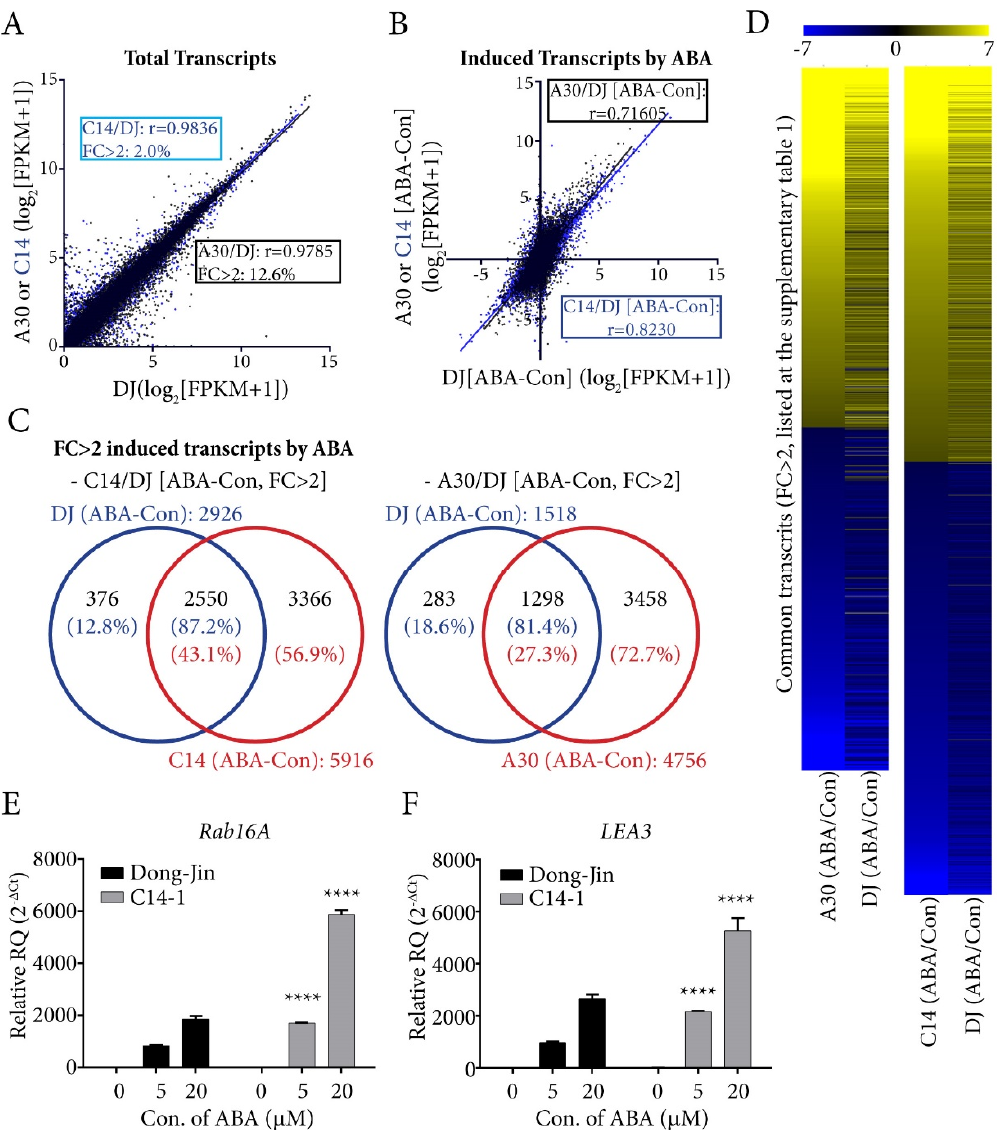
Figure 4. Comparative transcriptome analysis of transgenic rice overexpresing OsPYL / RCAR7 and OsPYL / RCAR3 . ( A ) Total transcripts of C14 (transgenic plants over-expressing OsPYL / RCAR7 ) (blue) and A30 (transgenic plants over-expressing OsPYL / RCAR3 ) (black) treated with no ABA were compared with DJ (wild type). ‘ r ’ is pearson correlation coe ffi cient. FC is fold change. ( B ) Induced or reduced transcripts in C14 (blue) or A30 (black) treated with ABA were compared. ( C ) Venn diagram of transcripts with more than twofold changes under ABA treatment. ( D ) Heat map of common trascripts (fc > 2). ( E , F ) Quantitative reverse transcription polymerase chain reaction (RT-qPCR) analysis with ABA dependently induced gene. Each transcript was detected in treated samples with indicated ABA treatment for 12 h. Similar expression levels were observed in triplicates. Error bars are SD. **** means that p -value is less than 0.0001. FPKM, fragment per kilo base of transcript per million mapped